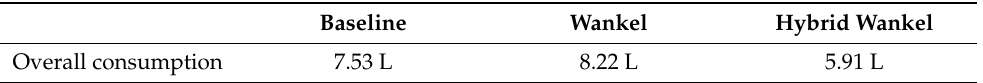
Table 4. Overall consumption of the three configurations over the “normal operation” mission.